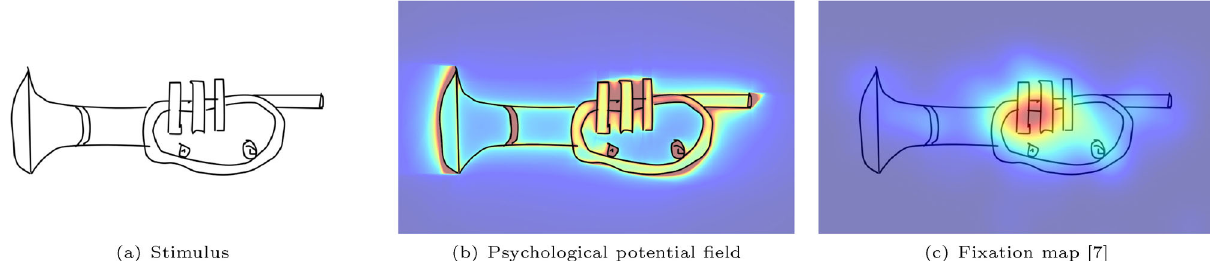
Fig. 1 PPF and fixation map. Red to blue indicates high to low